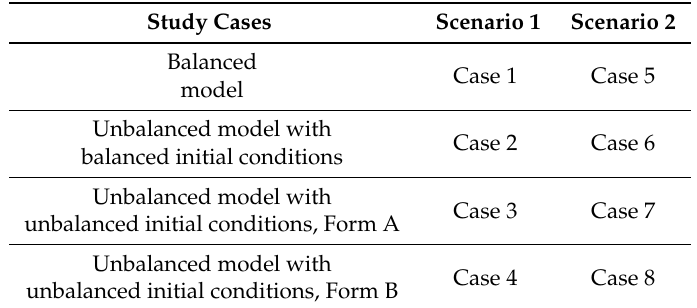
Table 4. Cases used to evaluate the three-phase unbalanced